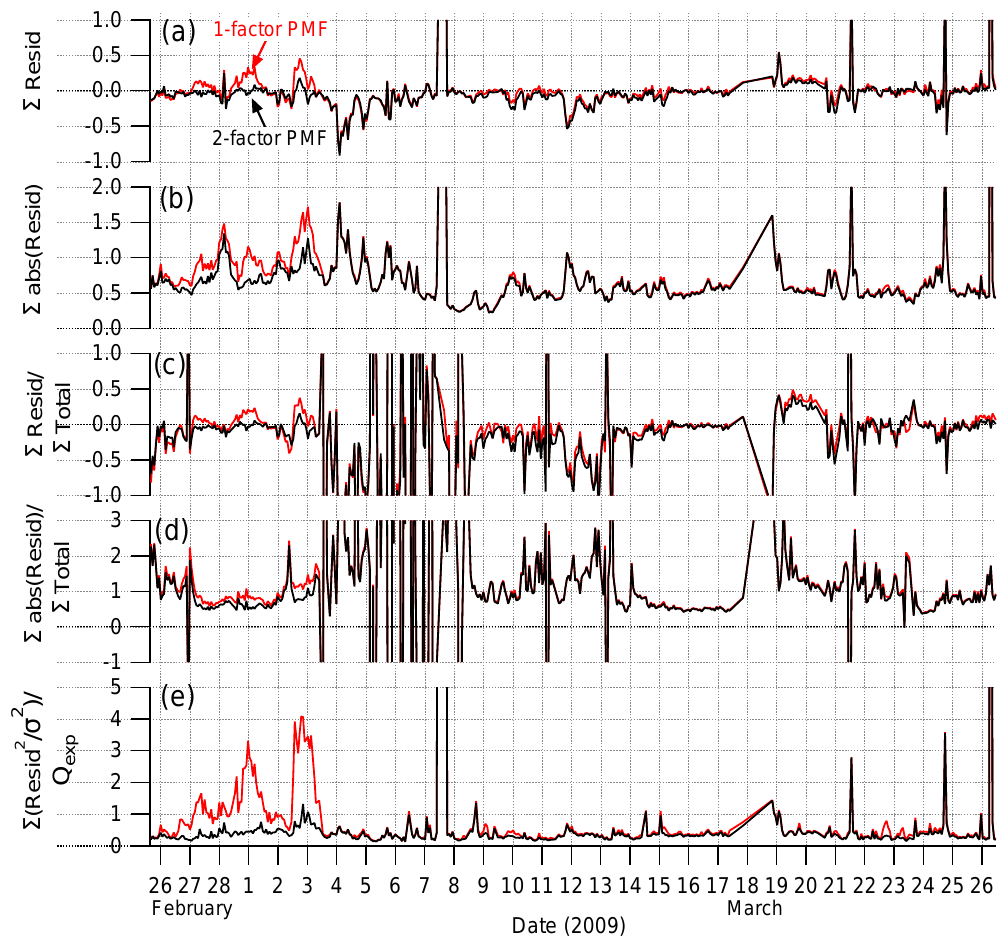
Fig. A1. Model residuals, E = X − GF , for the 1-factor (red lines) and the 2-factor (black lines) PMF solutions as a function of time (summed over all m/z ’s) calculated in five different ways: (a) sum of residuals; (b) sum of the absolute value of residuals; (c) sum of residuals relative to total organics; (d) sum of absolute value of residuals relative to total organics, and (e) sum of squared, uncertainty-weighted (“scaled”) residuals, Q(t) = E(t)/S(t) , relative to expected values, Q exp (t) . Plots obtained with the PMF evaluation tool, PET, by Ulbrich et al. (2009). The structure in the residuals is decreased significantly in the p = 2 solution compared to the p = 1 solution, especially during the first week of the campaign. Low OA concentrations result in high values for (c) and (d) during 4–9 March. Table A1. Correlations of PMF factors ( f i ) with ancillary data: 2-factor PMF solution. a SO 2 −